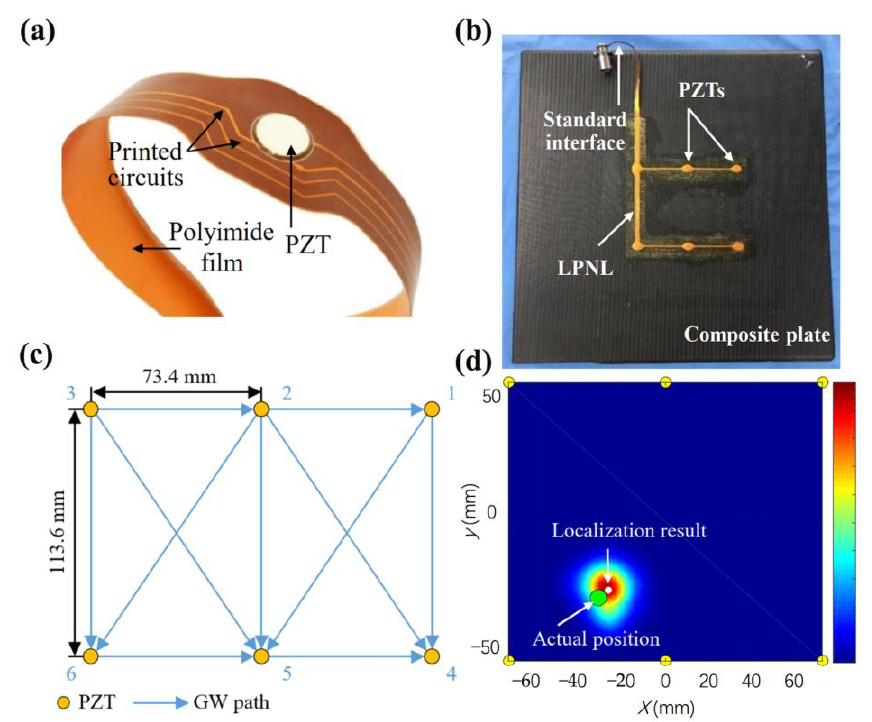
Figure 9. ( a ) Small section of LPNL and ( b ) the adopted LPNL, ( c ) its placement, ( d ) its imaging result of damage [91].